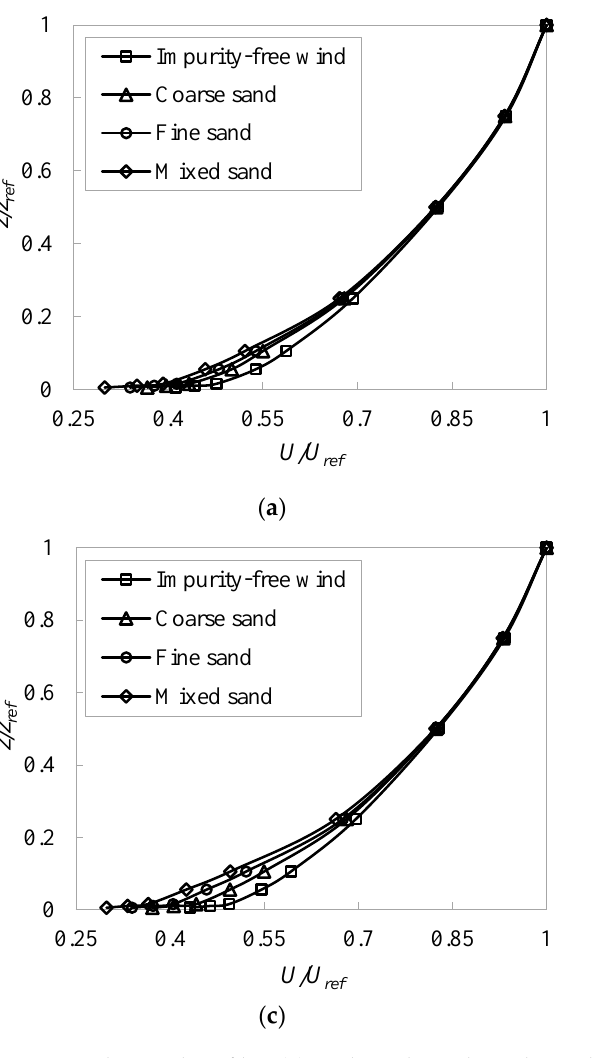
Figure 10. The wind profiles: ( a ) At the indicated wind speed of 14.74 m/s; ( b ) At the indicated wind speed of 16.68 m/s; ( c ) At the indicated wind speed of 18.61